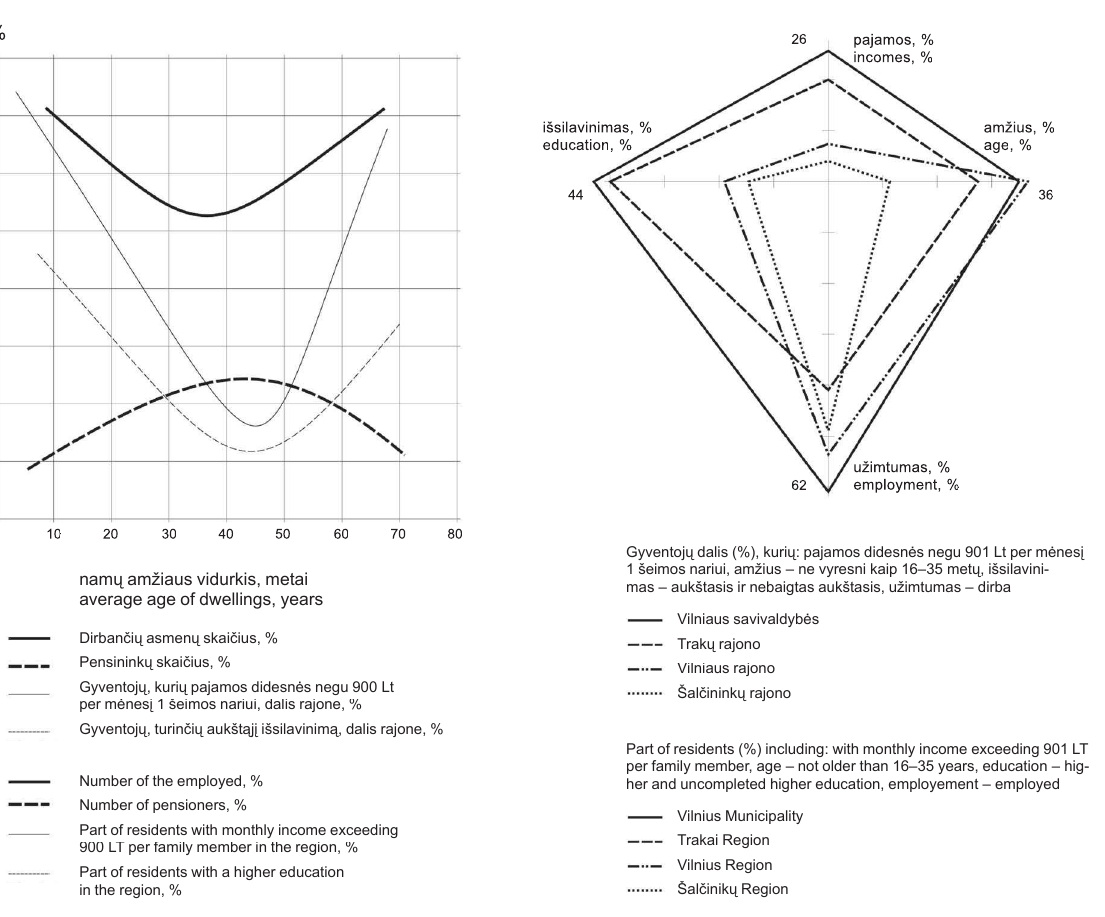
Fig 2 . Link between income, education, employment and housing age for 16–74 year old residents (2005)